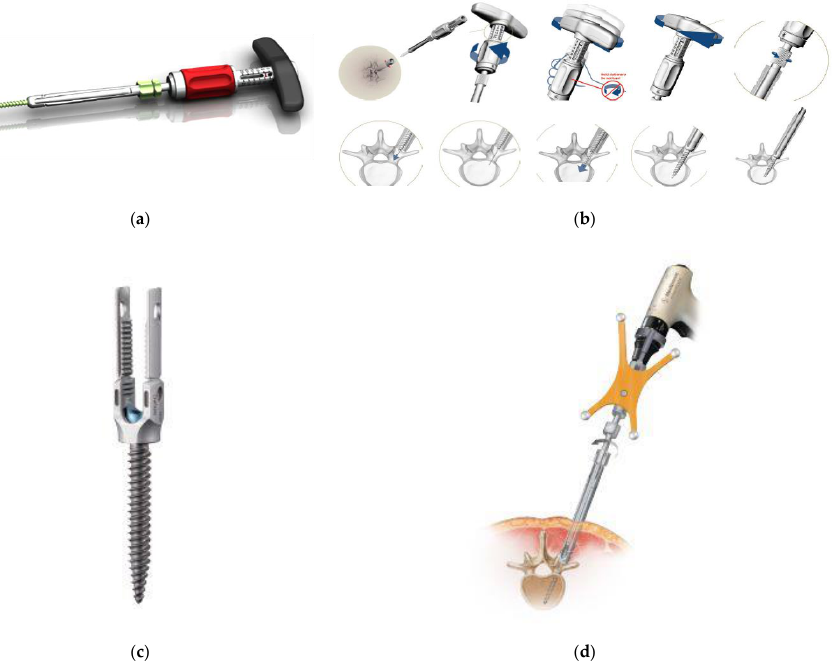
Figure 4. Third-generation PPS systems (CREO ® , Saccura ® , and IBIS ® ). CREO ® ( a , b ) , Saccura ® ( c ), and IBIS ® ( d ).